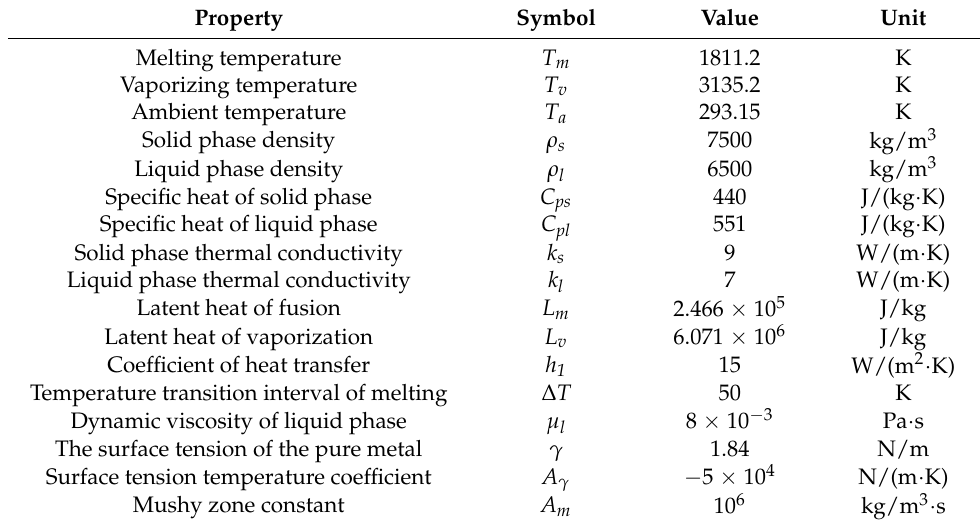
Table 1. Physical parameters of NdFeB